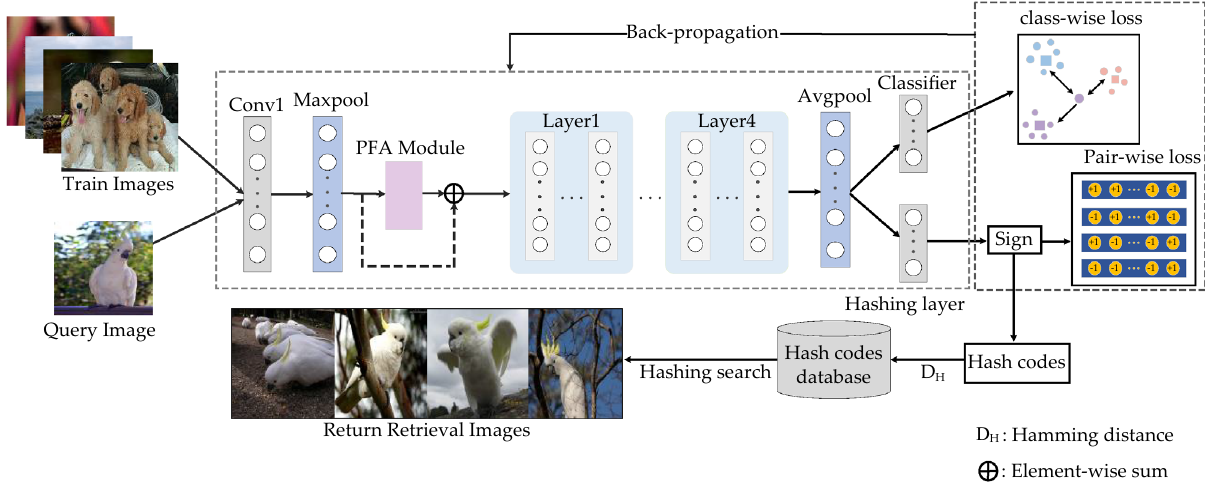
Figure 1. The overall framework of deep parameter-free attention hashing module, which is composed of three parts: (1) pairs of images are fed into Convolution and Maxpool layer to obtain feature map; (2) features map is fed into the PFA module, and the result obtained perform the element-wise sum operation with feature map; (3) a hashing layer is designed to generate hash codes, and three loss functions are used to optimize the network. (Created by ‘Microsoft Office Visio 2013’ url: https:// www. micro soft. com/ zh- cn/ micro soft- 365/ previ ous- versi ons/ micro soft- visio-